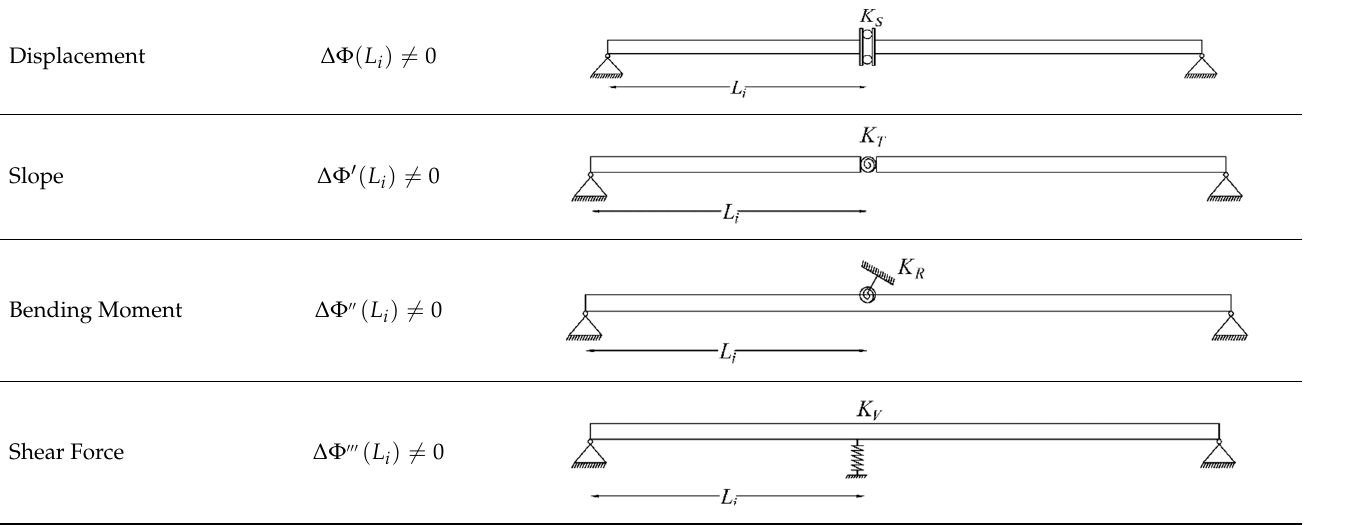
Table 1. List of beam discontinuities.